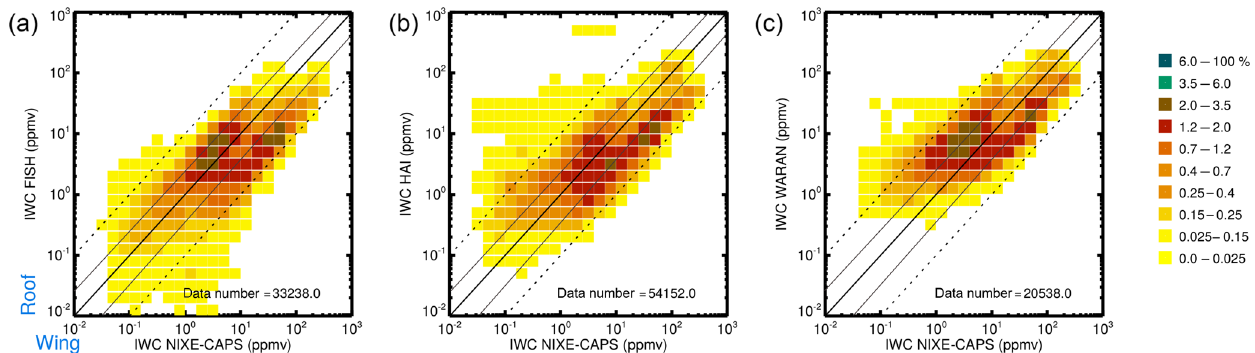
Figure 10. Comparison of IWCs from roof-mounted closed-path hygrometers FISH, HAI and Waran (see Eq. 1, H 2 O gas from SHARC) and wing-mounted cloud spectrometer NIXE @HALO during ML-CIRRUS 2014 (color code: frequencies; solid black: 1:1 line; dashed/thin: ± factor 10/2.5 to 1:1 line).